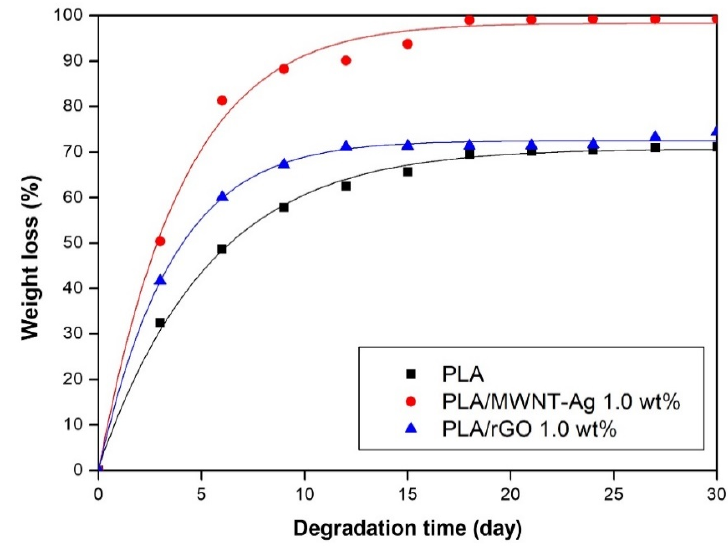
Figure 10. Degradation of PLA-based films.